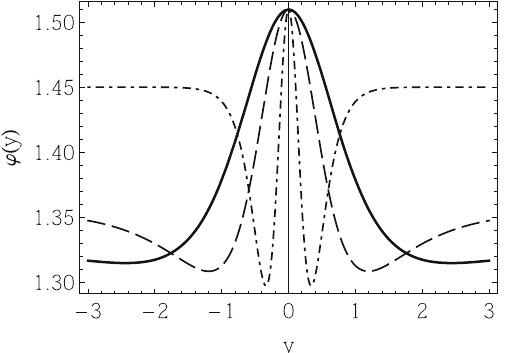
Fig. 15 Numerical plot of ϕ( y ) for ψ 0 = 1 and ϕ 0 = 1 . 51, with λ = 0 (solid line), λ = 0 . 4 (dashed line), and λ = 0 . 8 (dot-dashed line)